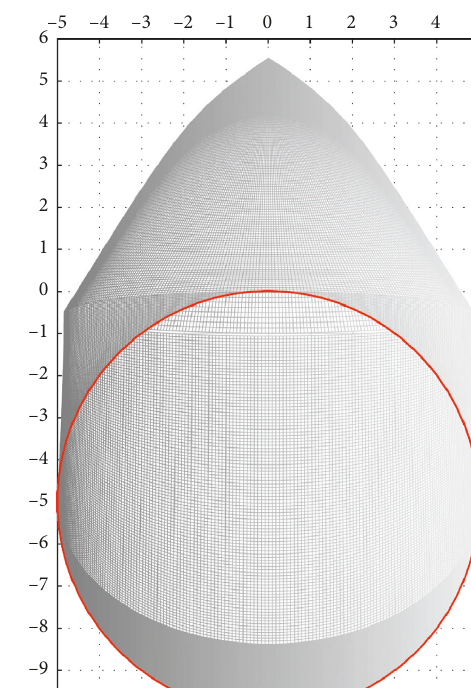
7kPa and φ 17 ° . (cid:29) (cid:29)